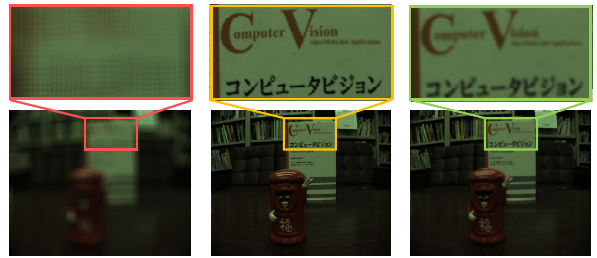
Figure 10. Example of multi-focus